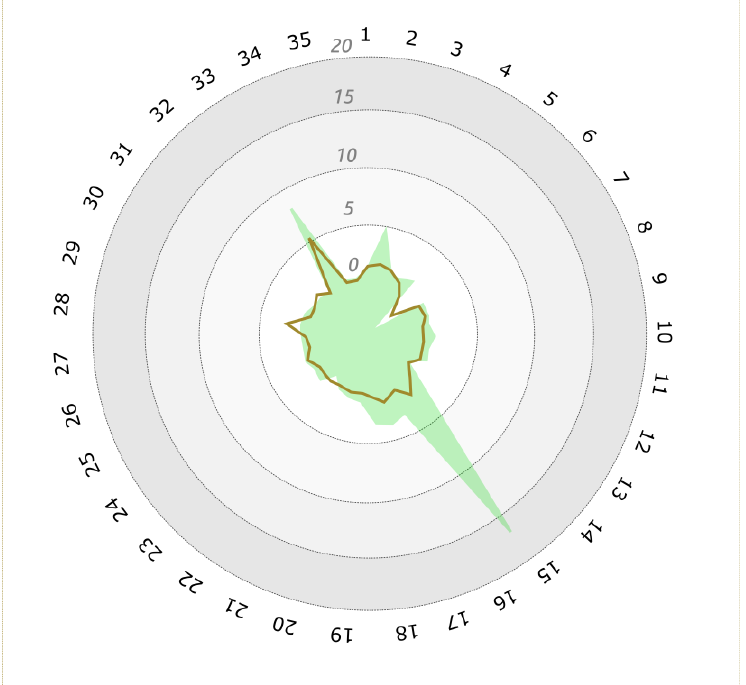
Figure 6. Radar plot of the average values of selected indices (green line and shade: June data, healthy; brown line: November data, declining). The plot supported the identification of useful indices for further exploration and use in the Random Forest model (Compare with results of [19]). Index numbers can be found on Table